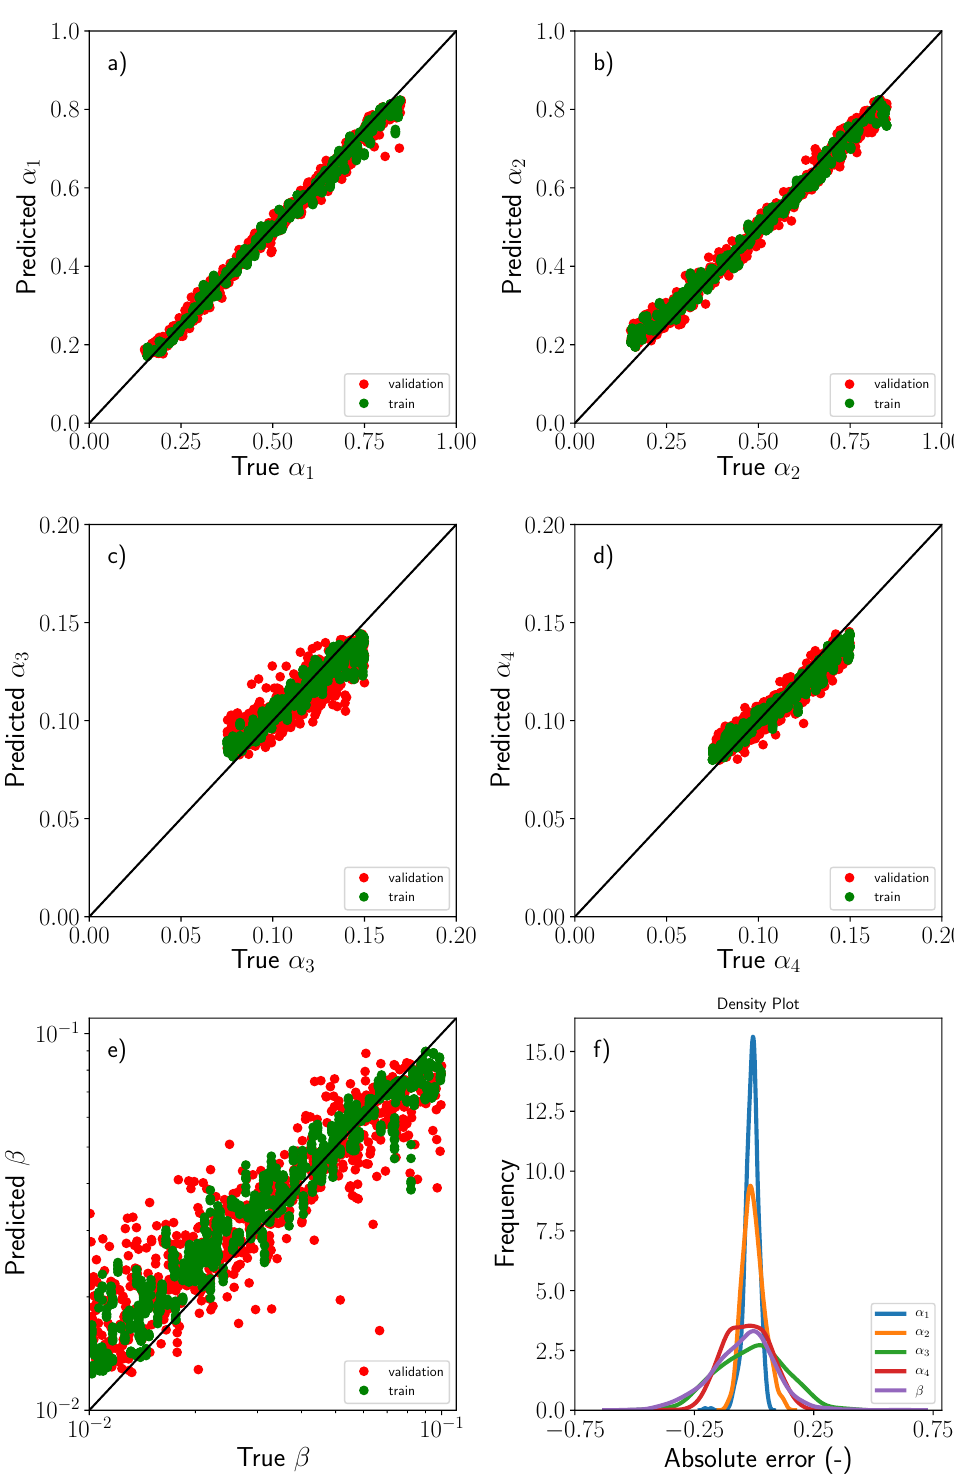
Figure 8. Comparisons between the ground truth values of the variables, ( a ) α 1 , ( b ) α 2 , ( c ) α 3 , ( d ) α 4 and ( e ) β including training (green) and test (red) data sets, ( f ) Histograms of the absolute error corresponding to each of the variables used in the